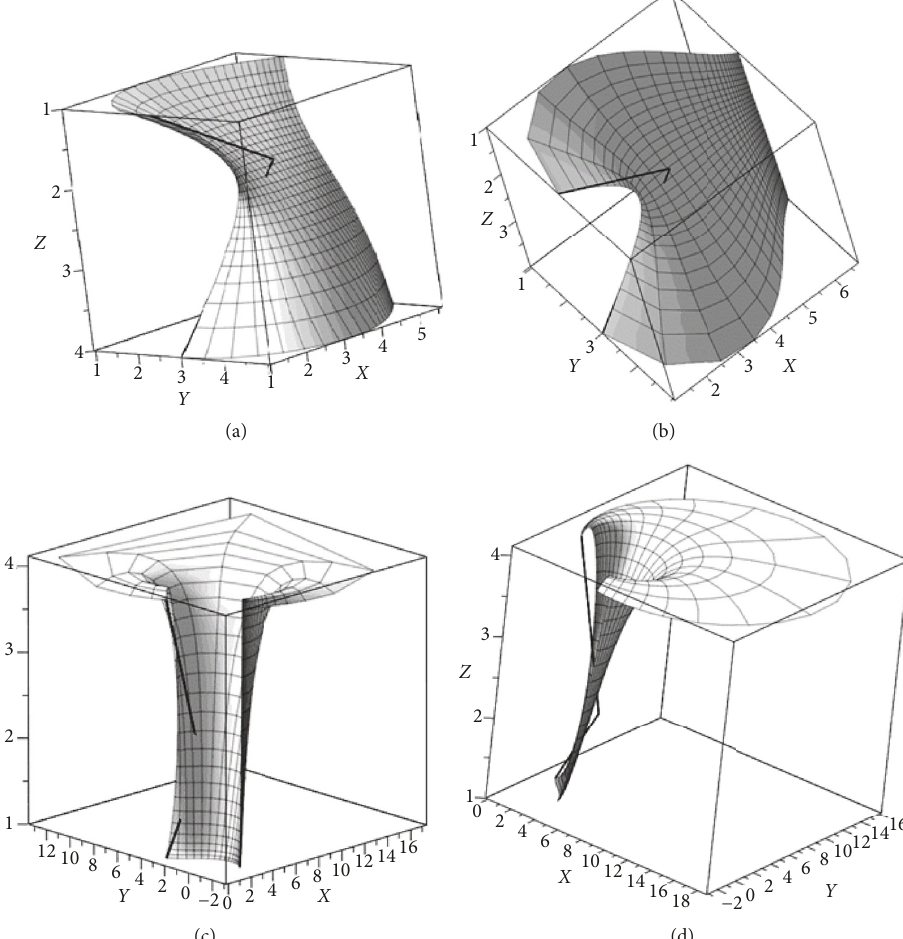
Figure 8: Surfaces based on a fractional-rational curve of the second order and a flat isotropic grid. The reference points are connected by broken bold line. (a) Real values of weights, 𝑡 = 𝑢 + 𝑖 V . (b) Real values of weights, 𝑡 = 𝑢 + 𝑖3 V . (c) Complex values of weights, 𝑡 = 𝑢 + 𝑖 V . (d) Complex values of weights, 𝑡 = 𝑢 + 𝑖3 V